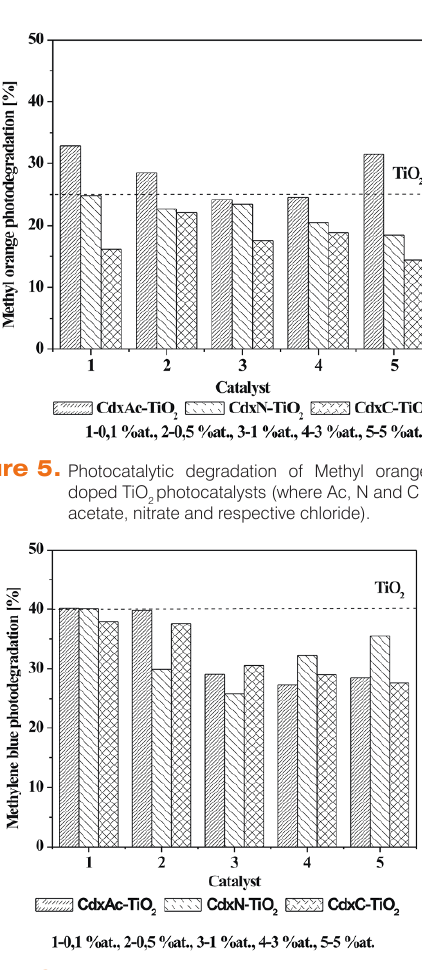
Figure 6. Photocatalytic degradation of Methylene blue vs. Cd doped TiO photocatalysts (where Ac, N and C represent 2 acetate, nitrate and respective chloride).